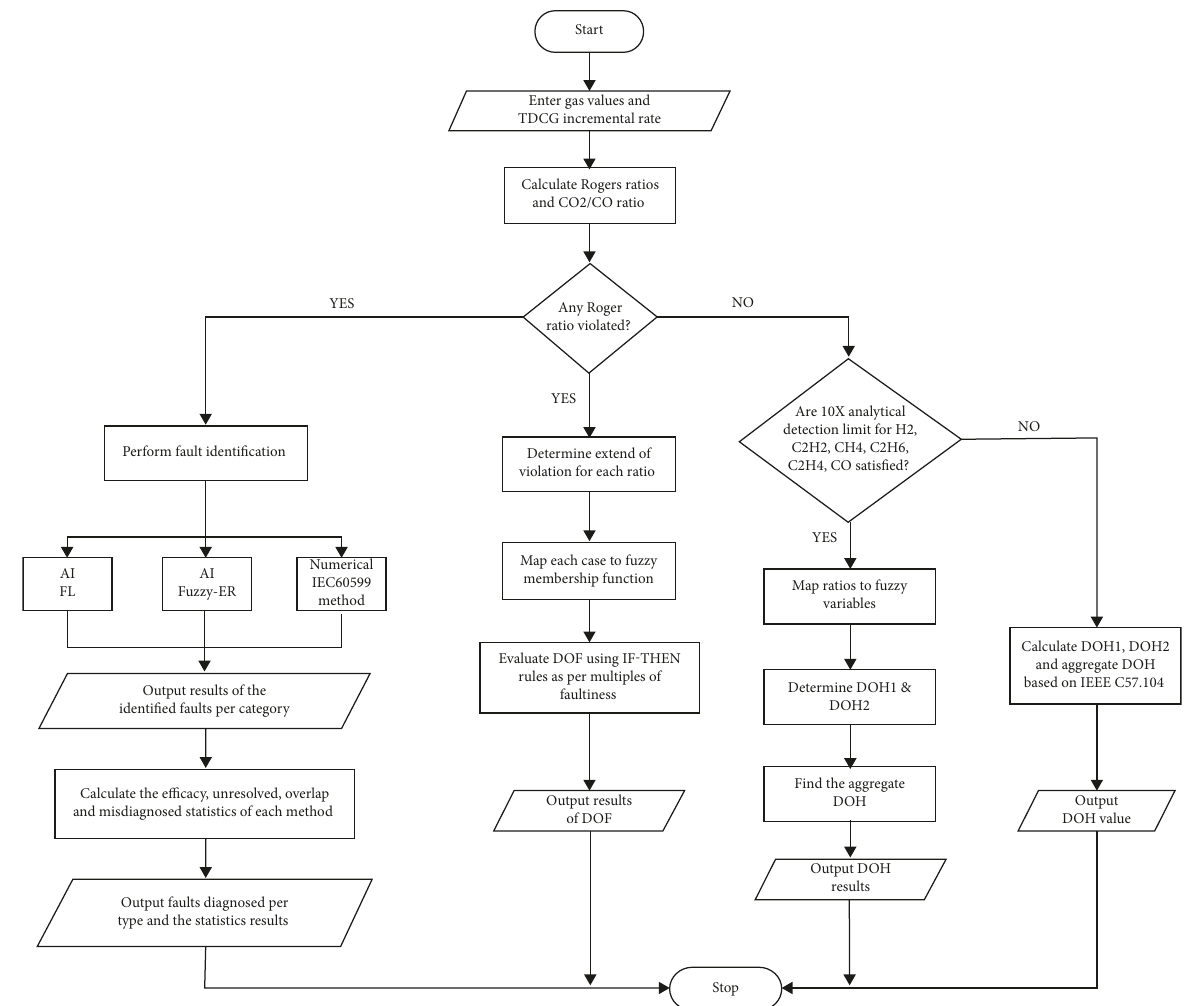
Figure 7: Flowchart for the algorithm for DOH, DOF, and fault diagnosis evaluation